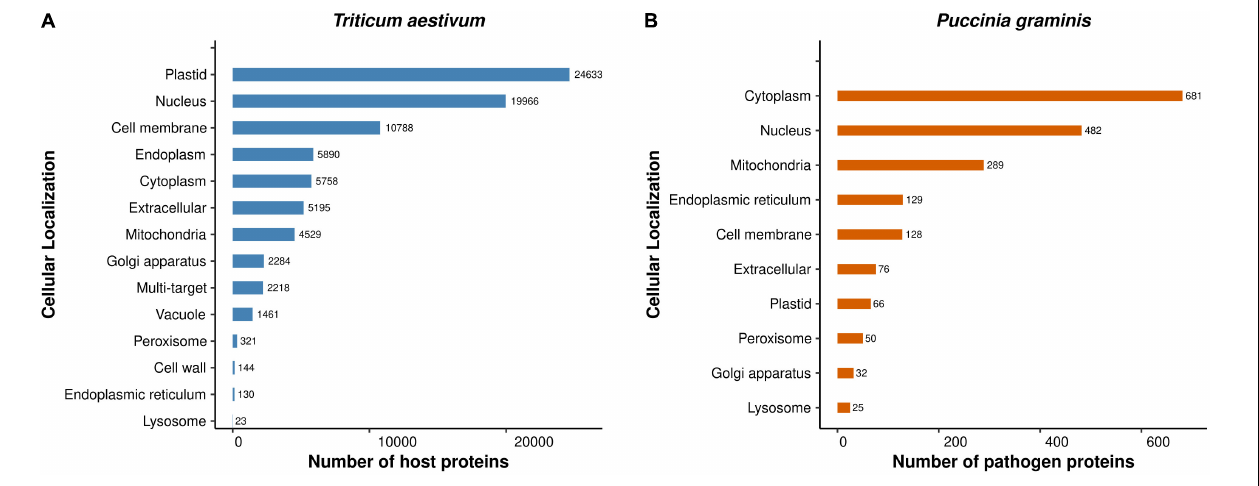
FIGURE 5 | Subcellular Localization of the (A) host proteins, and (B) pathogen proteins involved in the common subnetwork.